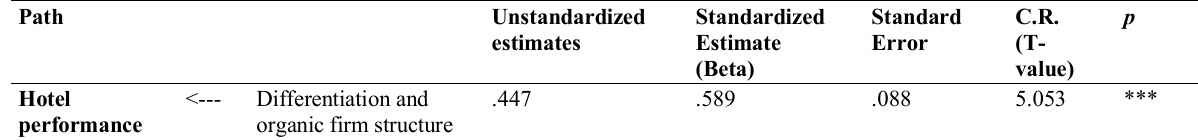
Table 3: Regression weights on joint differentiation strategy and organic firm structure on hotel performance